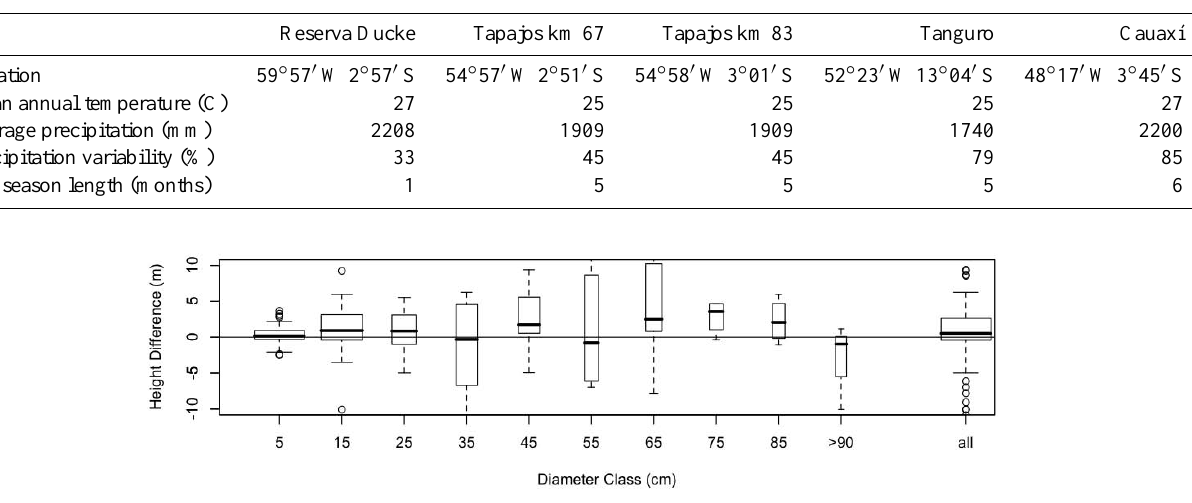
Table 2. Site locations and climatic characteristics.